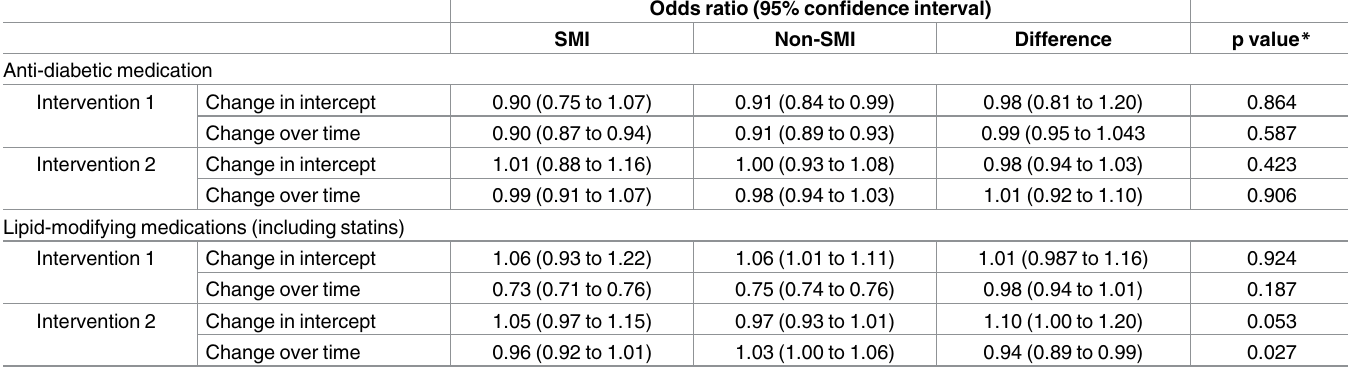
Table 3. Interrupted time series analyses results, reporting immediate changes in treatment of cardiovascular risk factors and changes over